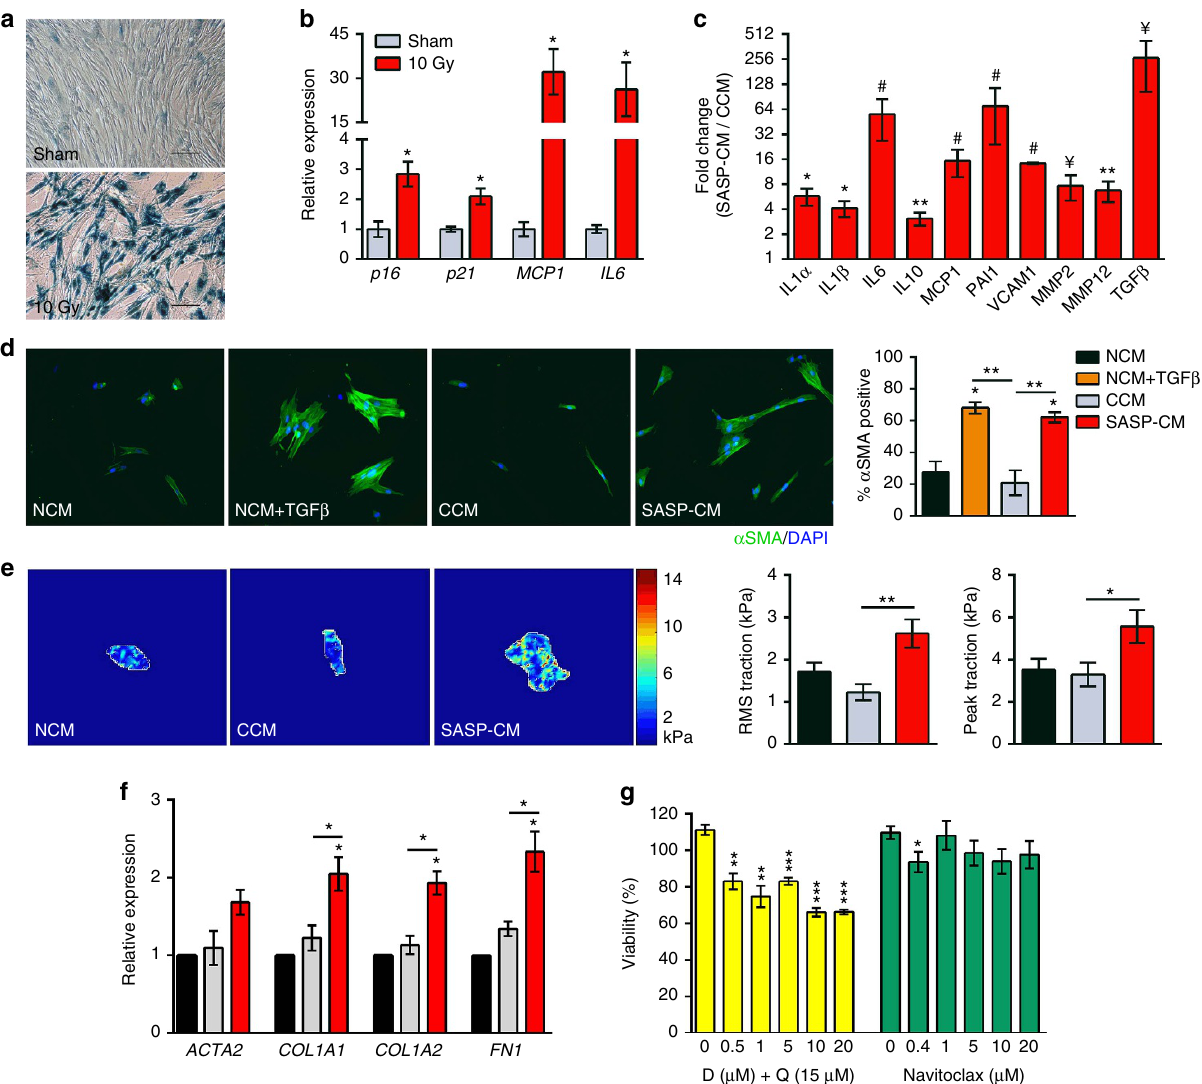
Figure 3 | The secretome of senescent fibroblasts is profibrotic. IMR90 lung fibroblasts were exposed to irradiation (10Gy). Twenty-one days later, senescence was confirmed by ( a ) SA- b -gal staining (scale bar, 100 m m) and ( b ) RT–PCR assessment of p16 , p21 , MCP1 and IL6 expression relative to TBP levels in 10Gy exposed (red) and sham-treated (grey) cells (mean ± s.e.m.; n ¼ 3, * P r 0.05), as well as ( c ) immunoanalysis of secreted SASP components within 10Gy-exposed CM (SASP-CM), relative to CCM (mean ± s.e.m.; n ¼ 4, ** P o 0.01, * P r 0.05, f P ¼ 0.08 and # P r 0.1.) ( d ) IMR90 cells were treated with media collected 21 days post 10Gy, -sham exposure or control as follows: NCM (black), NCM þ 2ngml (cid:2) 1 TGF b (orange), CCM (grey) or SASP-CM (red). IMR90 cells were treated with the indicated media for 72h then immunostained for a SMA (green) and DAPI (blue). Percentage a SMA-positive cells were determined blindly, using a visual threshold (mean ± s.e.m.; n ¼ 2–4 independent experiments; ** P o 0.01 and * P r 0.05). ( e ) IMR90 cells were plated onto 6.4 kPA matrices for traction force microscopy in the presence of the indicated media for 72h. Representative traction heat maps, root mean square (RMS) traction and peak traction are depicted (mean ± s.e.m.; n ¼ 2–4 independent experiments with a minimum of 20 independent cells per condition; ** P o 0.01 and * P r 0.05 versus control CM). ( f ) IMR90 cells were treated with indicated media for 72h before RNA isolation. RT–PCR expression of ACTA2 , COL1A1 , COL1A2 and FN1 were measured relative to GAPDH levels (mean ± s.e.m.; n ¼ 2–4 independent experiments, * P r 0.05). ( g ) Human primary lung fibroblasts were exposed to irradiation (10Gy). Twenty days post irradiation, cells were treated with the indicated concentrations of DQ (yellow) or navitoclax (green). Cell viability 3 days after drug treatment was measured by ATPLite assays and is indicated as a percentage of plating density at day 0 of treatment. (mean ± s.e.m.; n ¼ 4, t -test, *** P o 0.001, ** P o 0.01 and * P r